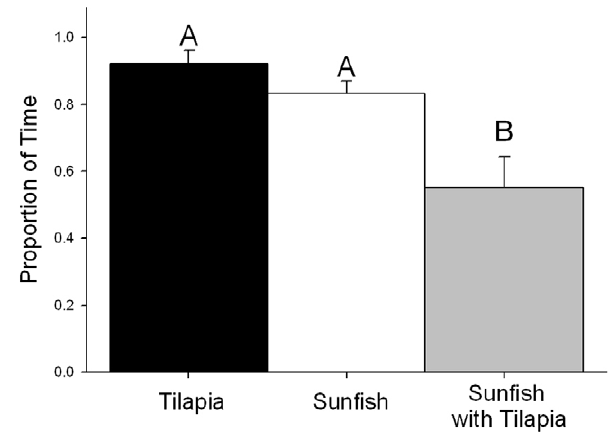
Figure 1. Proportion of time (s; mean ± 1 standard error) spent in structured habitat during lab trials for each species treatment. Differences in upper case letters indicate significant differences between treatments (p #